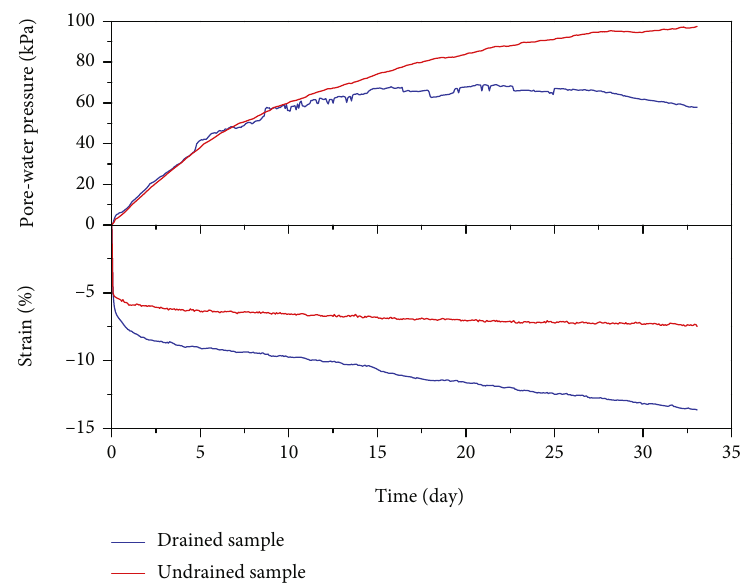
Figure 9: E ff ect of drainage conditions on test results (KY-03 and KY-04).